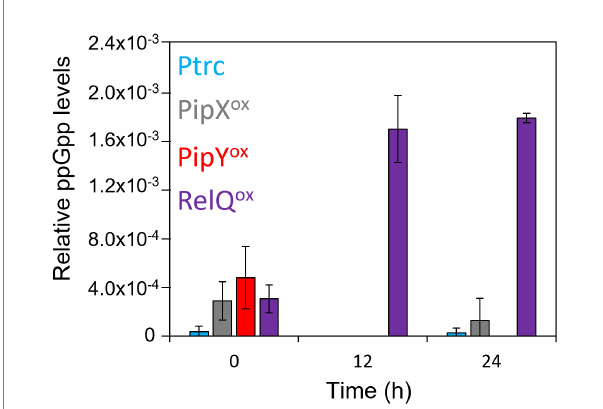
FIGURE 7 The stringent response is not induced by PipY ox or PipX ox . Mass spectrometry analysis of relative ppGpp levels of strains grown under standard conditions with 50 μ M IPTG for 0, 12, and 24 h. Relative ppGpp levels in each sample are calculated as the area under the curve (AUC) of the extracted ion chromatogram (EIC) for ppGpp and normalized to the AUC of the EIC for phosphoric acid (H 3 PO 4 ). Data are presented as mean and error bars (standard deviation) of two biological replicates. Labels and data points are colored to indicate the strains as follows: Ptrc-light blue, PipX ox -gray, PipY ox -red, RelQ ox -